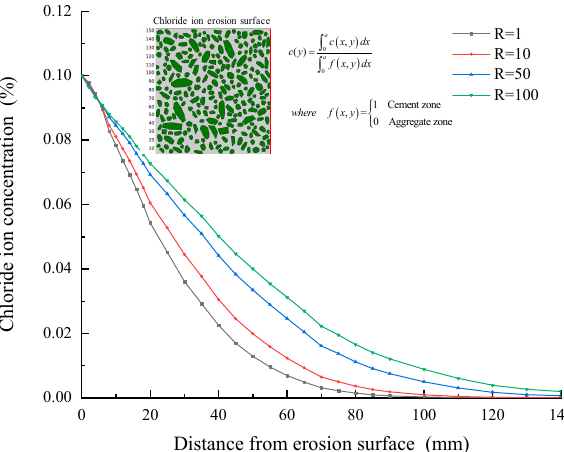
Figure 14. Chloride ion concentration–depth curve (R = 1\10\50\100).